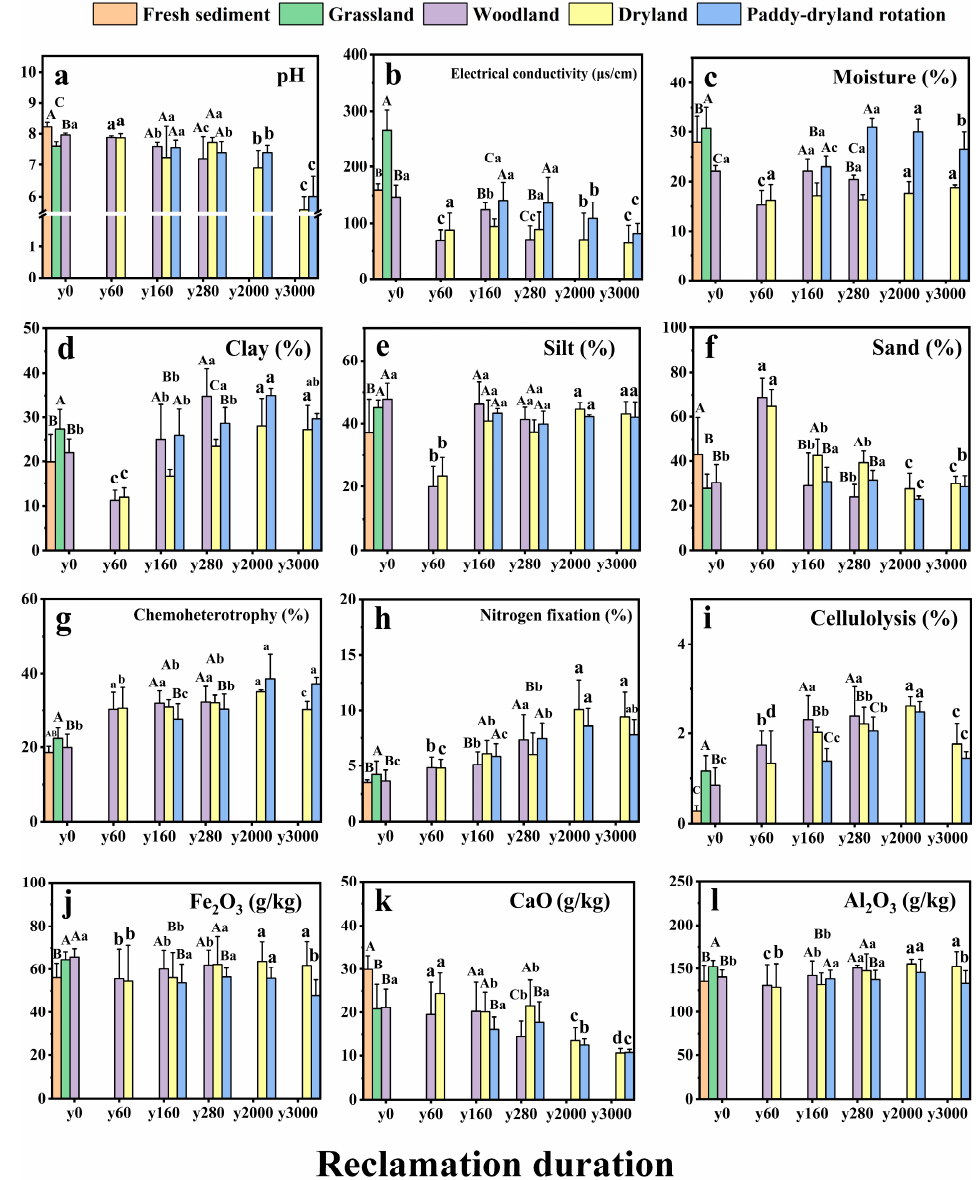
Figure 2. Evolutionary trends in soil environmental factors along the chronosequence in different land uses. ( a ) pH; ( b ) electrical conductivity; ( c ) moisture; ( d ) clay; ( e ) silt; ( f ) sand; ( g ) chemoheterotrophy; ( h ) nitrogen fixation; ( i ) cellulolysis; ( j ) Fe 2 O 3 ; ( k ) CaCO 3 ; and ( l ) Al 2 O 3 . Different uppercase letters indicate that means are significantly different ( p < 0.05) among land uses at the same reclamation stage. Different lowercase letters indicate means are significantly different ( p < 0.05) among the same land use across reclamation stages.